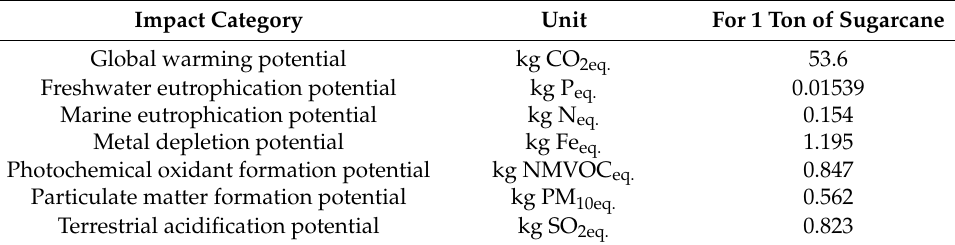
Table 3. Impact category indicator results in the agricultural stage to produce sugarcane (FU = 1 ton of sugarcane).